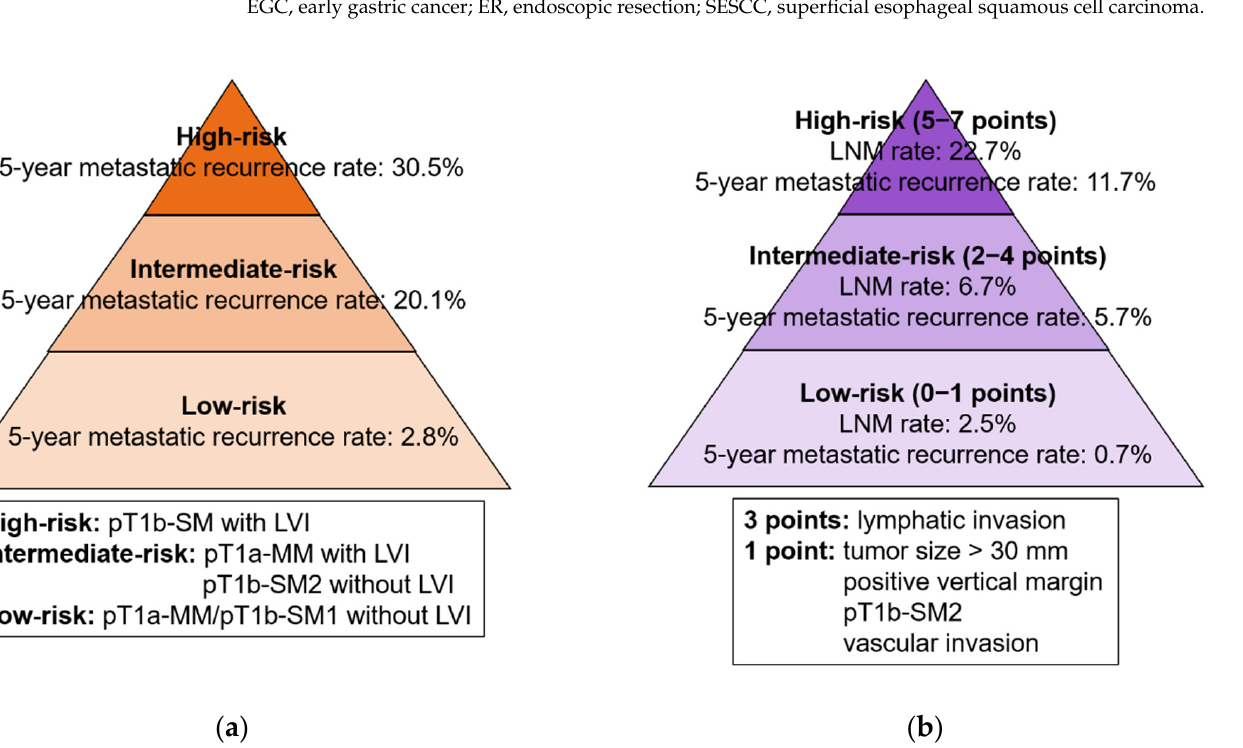
Table 1. Comparison between SESCC and EGC cases with metastatic recurrence after non-curative ER without additional treatment. SESCC EGC The rate of detection as locoregional recurrence 65.2% 21.4% among patients with metastatic recurrence The rate of no further recurrence among patients undergoing salvage treatment for metastatic 83.3% 20.0% recurrence The rate of patients with long-term survival and no further recurrence after salvage treatment among 47.8% 3.7% patients with metastatic recurrence EGC, early gastric cancer; ER, endoscopic resection; SESCC, superficial esophageal squamous cell carcinoma.